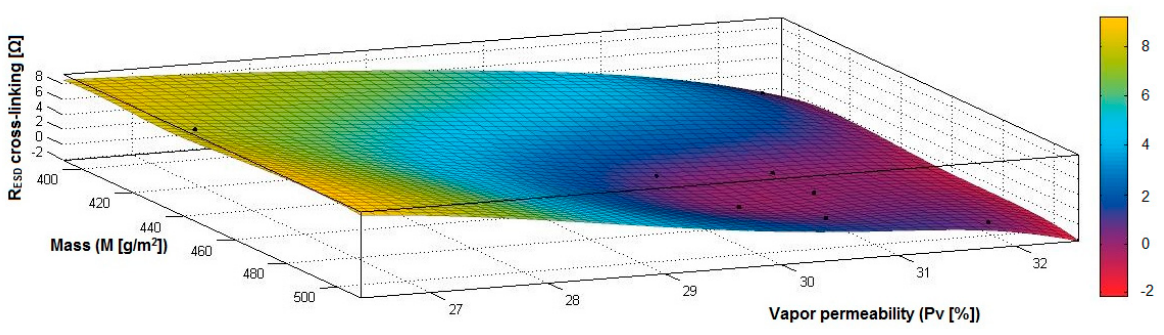
Figure 30. 3D representation R ESD after crosslinking = f(M, Pv) samples preliminarily treated in RF plasma O 2 using RF 1 generator and power 200 W.